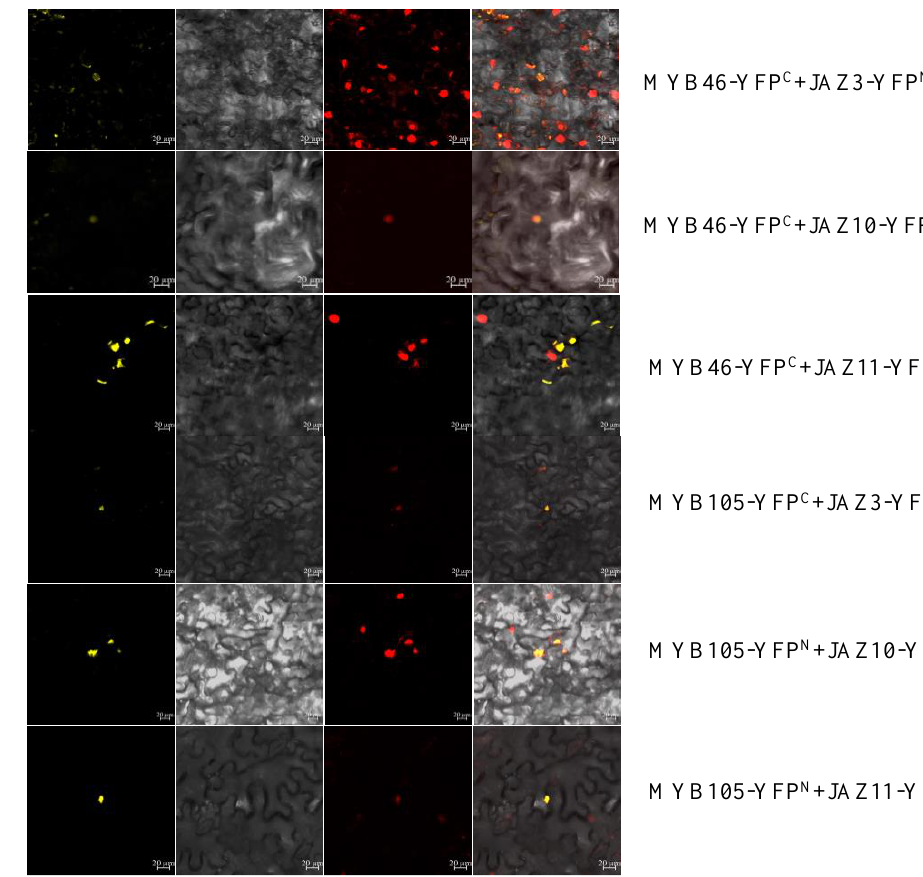
Figure 6. ( A ) Yeast self − activation activity assay of CsMYB45, CsMYB46, and CsMYB105. ( B , C ) Yeast two − hybrid assay ( B ) and BiFC assays ( C ) to screen for protein complex formation between the candidate CsMYBs and CsJAZ proteins. The interaction was verified by growth in SD/ − Trp − Leu − His medium. The BiFC assay was performed in tobacco leaves. The MYB proteins were fused with the N − terminal part of YFP, and the CsJAZ proteins were fused with the C − terminal part of YFP. Images are representative of at least three replicate experiments. Bar = 50 µm.